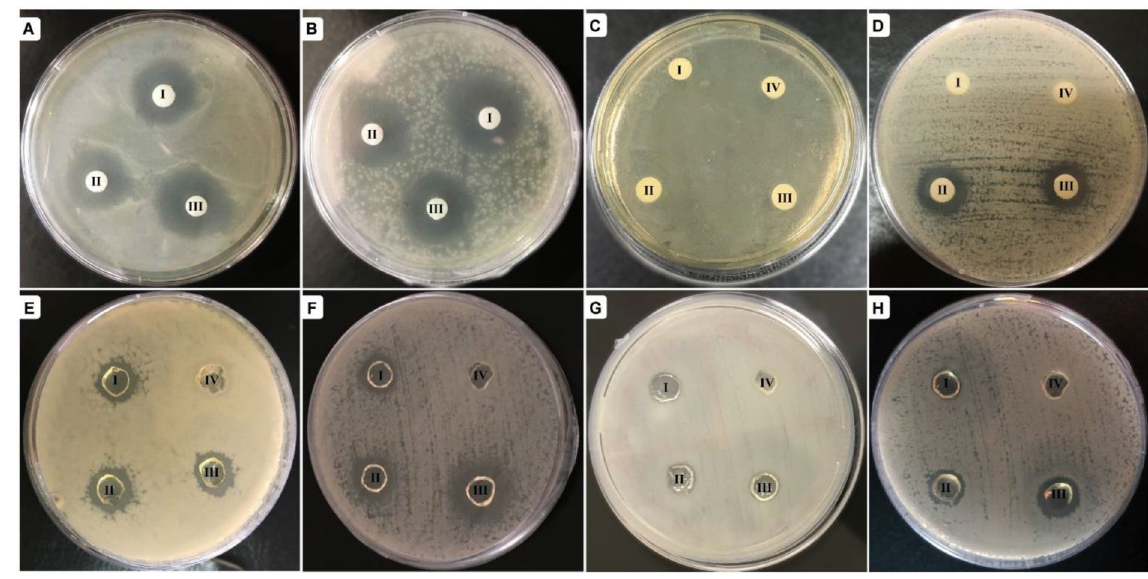
Figure 5. Inhibition zones around the prepared hydrogels. ( A – D ) Non-cross-linked and ( E – H ) cross-linked hydrogels. The plates in ( A ), ( C ), ( E ), and ( G ) are Escherichia coli cultures. The plates in ( B ), ( D ), ( F ), and ( H ) present Staphylococcus aureus cultures. In each plate, the hydrogels numbered as I–III contain 0.03, 0.08, and 0.15 mM nisin; number IV represents the control sample. In the plates displayed in ( A ) and ( B ), the controls are avoided due to repetition in the other 6 plates.